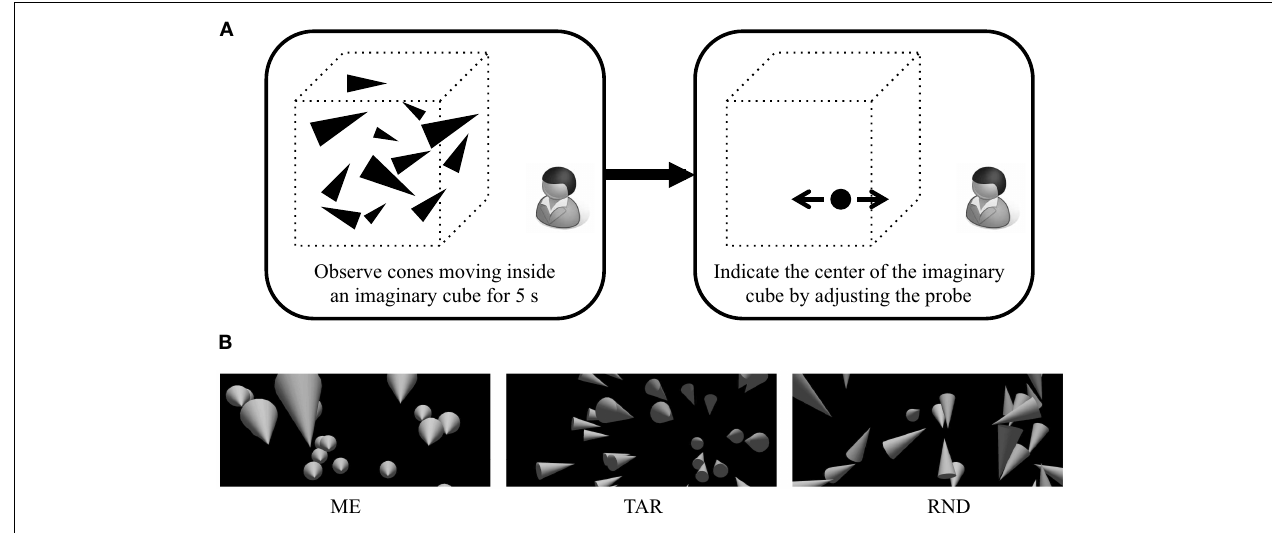
FIGURE 1 | (A) A schematic illustration of the experiment. The participants viewed virtual cones moving inside an imaginary cube for 5s, after which they indicated the center of the imaginary cube. (B) Example snapshots of a